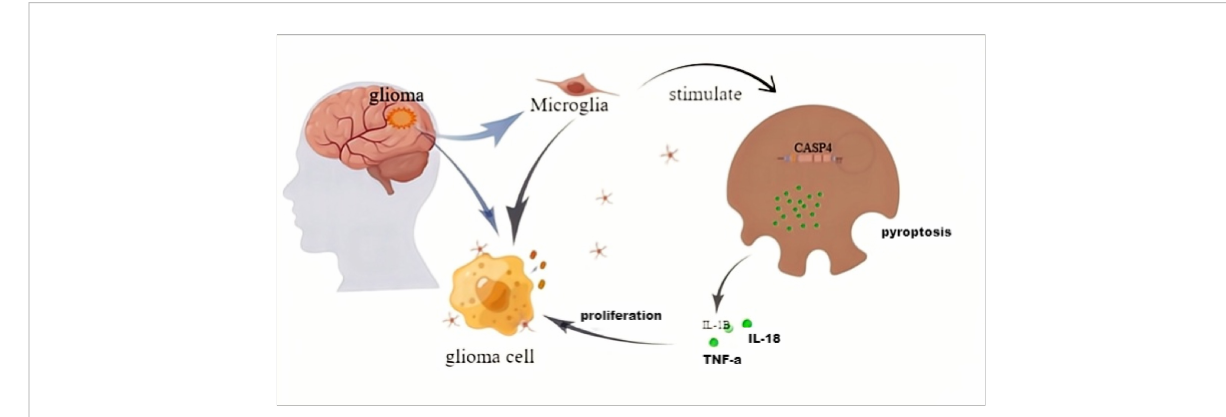
FIGURE 9 The schematic model of CASP4 affects the distribution of microglia and the proliferation of